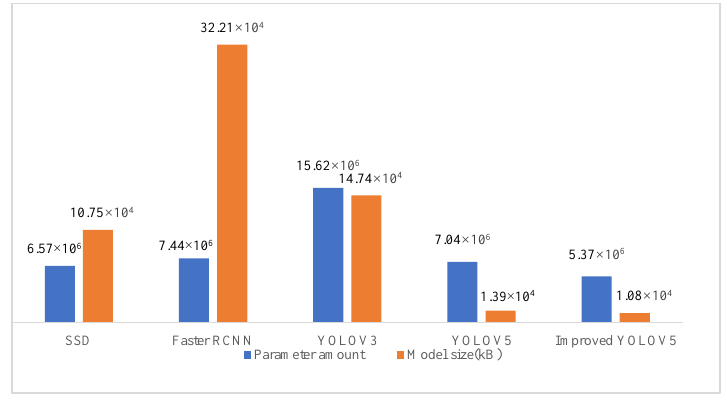
Figure 13. The parameter amount and model size of improved YOLOV5 and other methods.